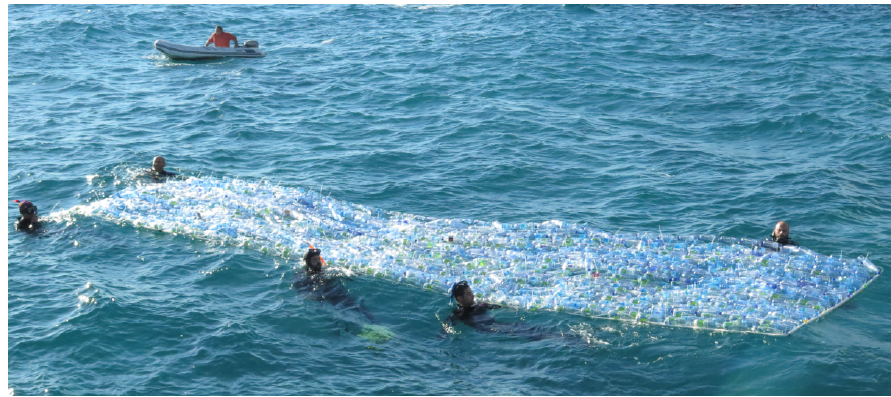
Figure 3. Divers moving target 200 meters from shoreline. Kyriacos Themistocleous.